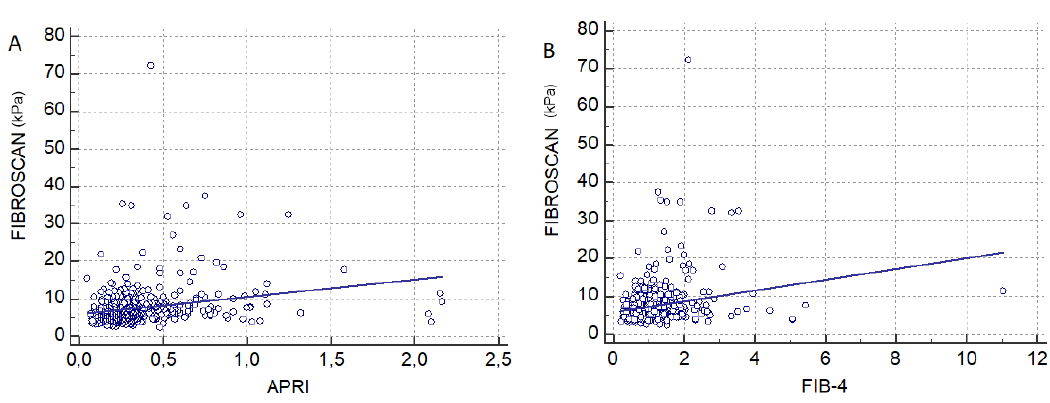
Figure 2. ( A ) Correlation between LSM obtain with Fibroscan and APRI score ( r = 0.22, p < 0.0001). ( B ) Correlation between LSM obtained with Fibroscan and FIB-4 score ( r = 0.21, p <